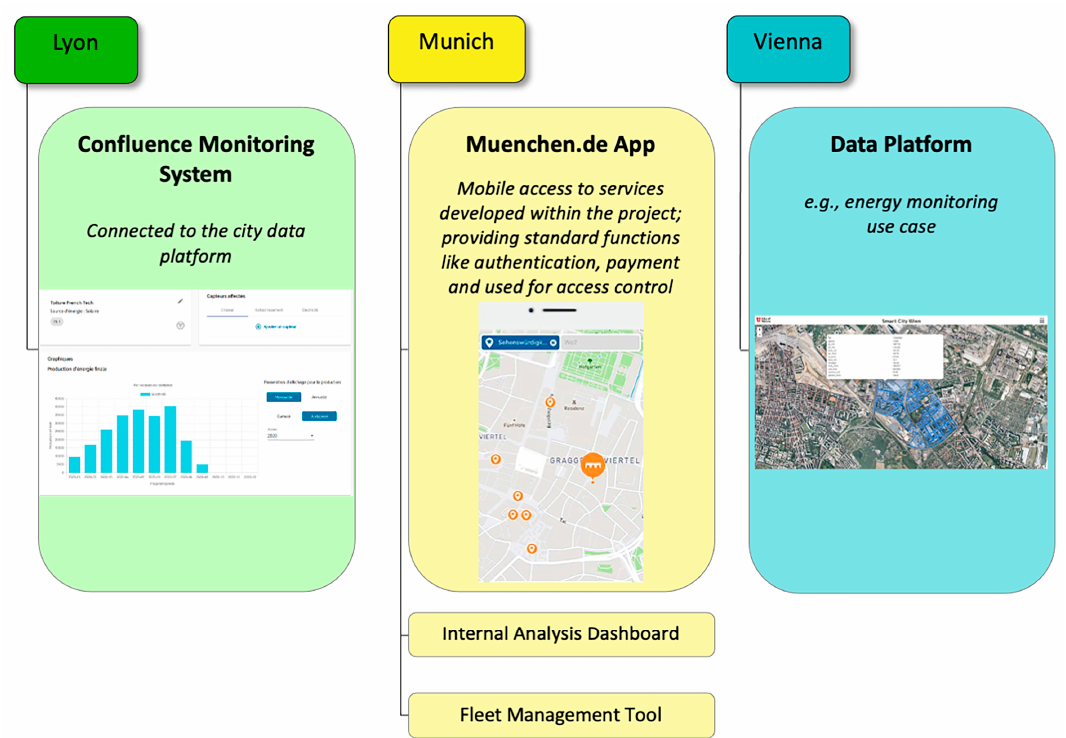
Figure 5. Visualizations of collected data on each city data platform in Lyon (left) [24], Munich (center) [25], and Vienna (right) [26].